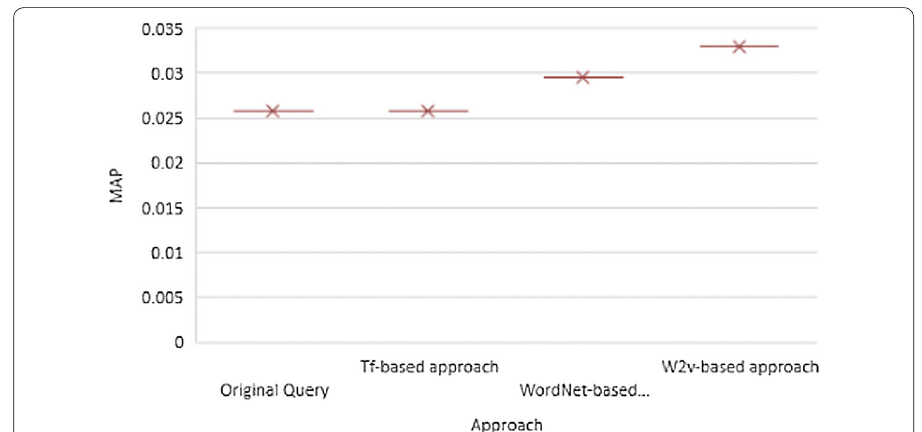
Fig. 8 Paired t‑test